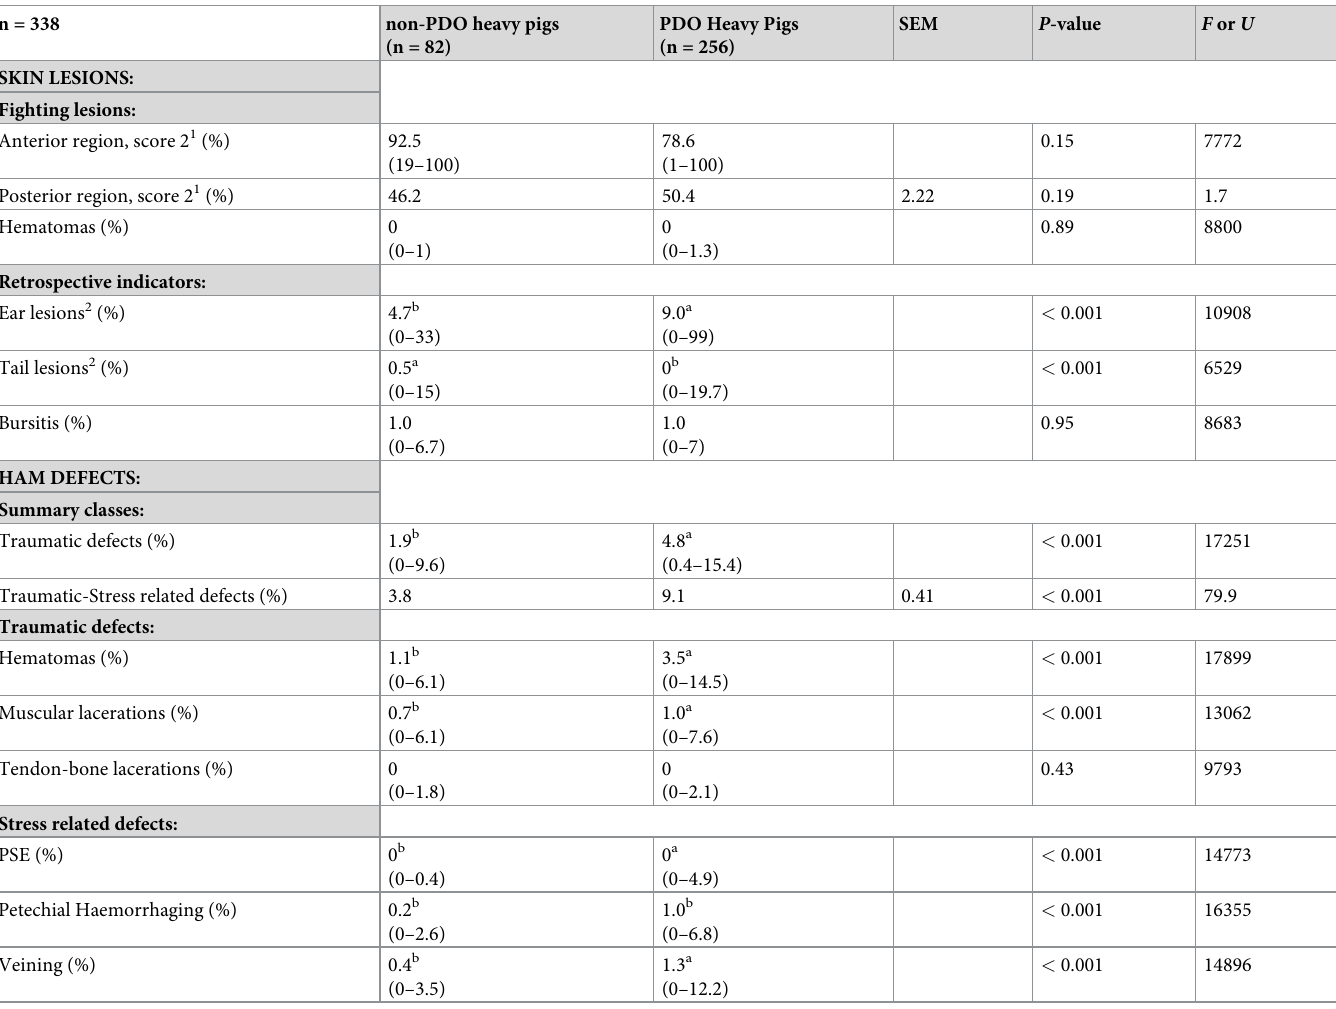
Table 5. Differences in the annual prevalence of skin lesions and ham defects between 256 batches of heavy Italian pigs destined for PDO production and 82 batches of Non-PDO heavy pigs.